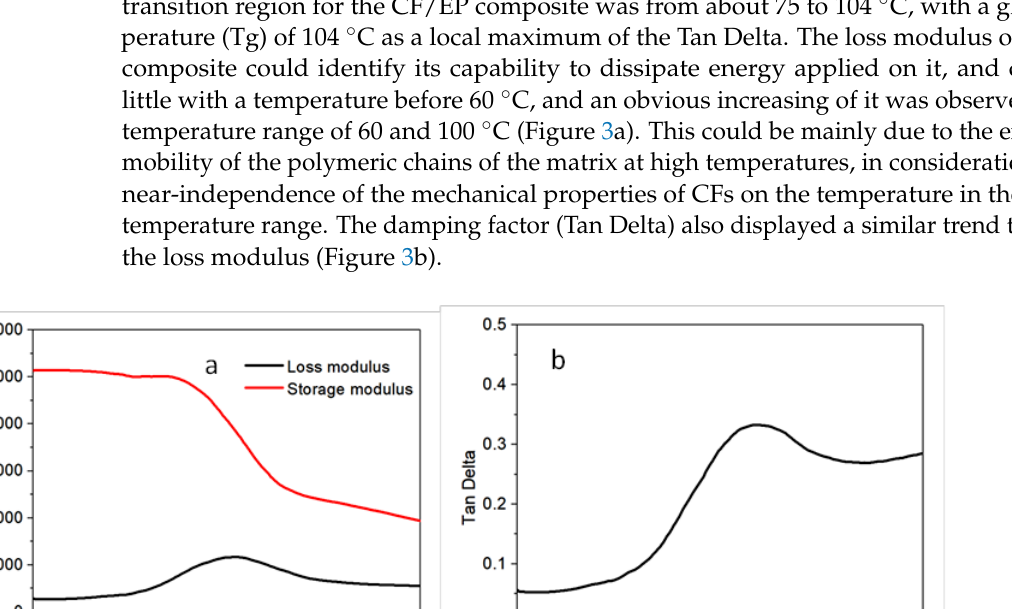
Figure 2. Infrared thermal imaging of CF/EP plates with different conduction currents: ( a ) The tem- perature response to the current loading time; the typical infrared photograph of the samples under the current loading of ( b ) 3 A, ( c ) 4 A and ( d ) 5 A.